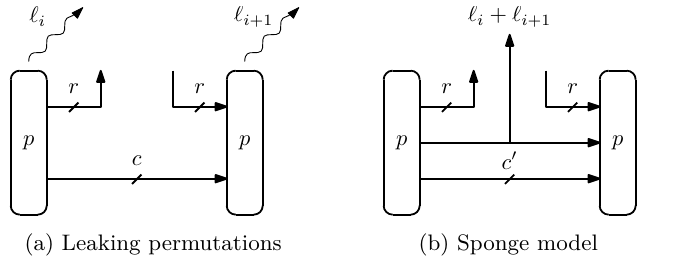
Figure 5: Leakage of information in sponge-based